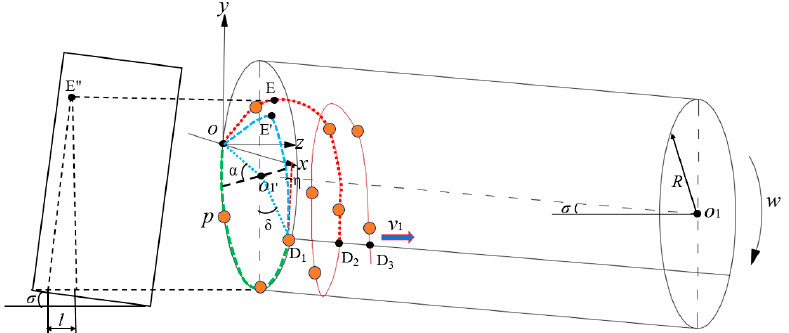
Figure 10. Kinematic analytical sketch of the BSF sand in the rotary screen. Note: w denotes the angular velocity of the cylinder sieve, rad·s − 1 ; w 1 is the angular velocity of the spike teeth, rad·s − 1 ; 𝜎 is the inclination angle of the trommel screen, °; η expresses the angle between the trajectory of the landing point and the vertical direction, °; R represents the radius of the cylinder sieve, m; 𝛼 is the angle between the particle and horizontal direction , °.